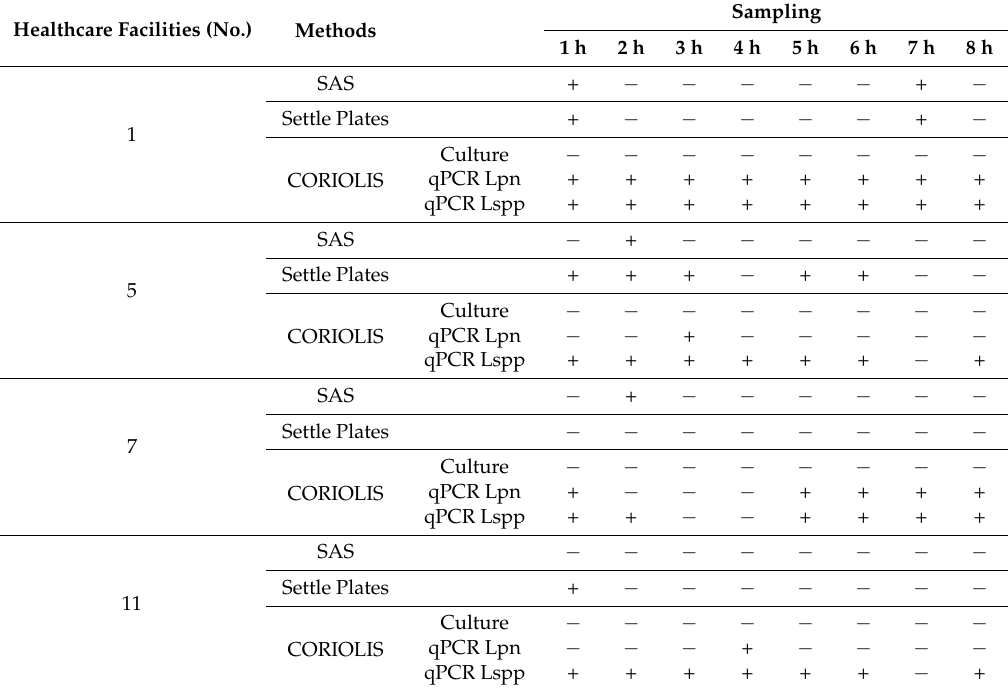
Table 2. Legionella air contamination in PG * by different sampling methods. Healthcare Facilities (No.) Methods